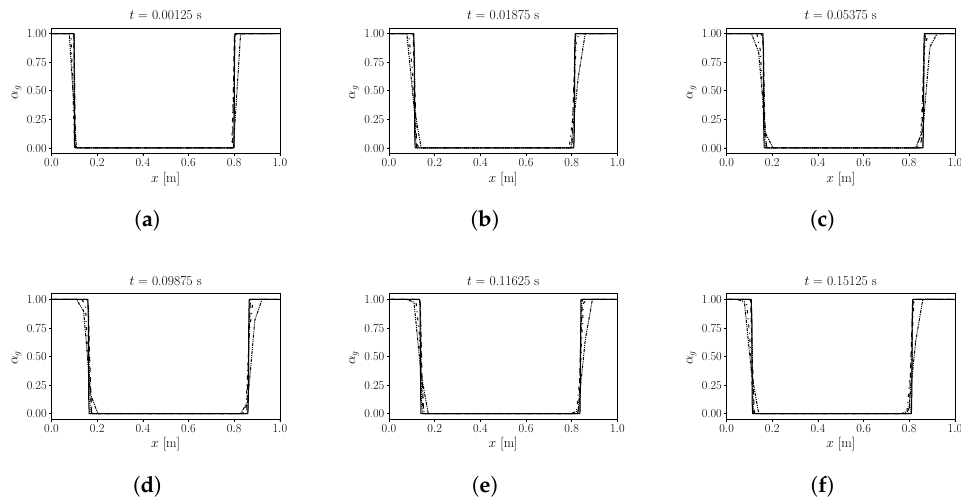
Figure 5. Oscillating water pipe. Evolution of void fraction α nc for the first oscillation; time evolution from right to left (( a – c ) and ( d – f )) They were simulated 5 grids. Legend: ( ) 512 cells; ( ) 256 cells; ( ) 128 cells; ( ) 64 cells; ( ) 32